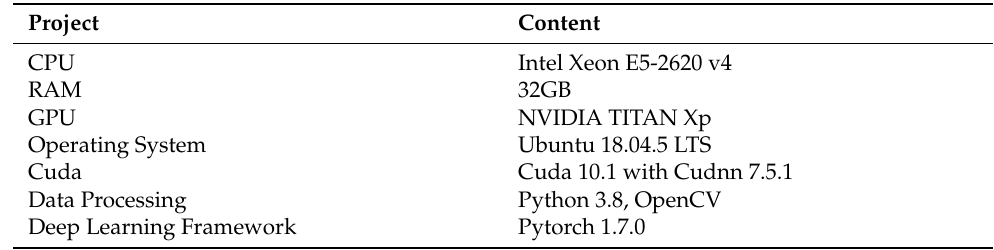
Table 1. Computer configuration.